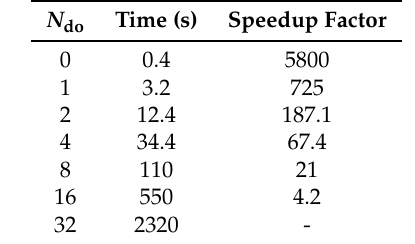
Table 4. Computational time in seconds of the radiative transfer solution as a function of the number of streams, and speedup factors with respect to the case N do = 32. N